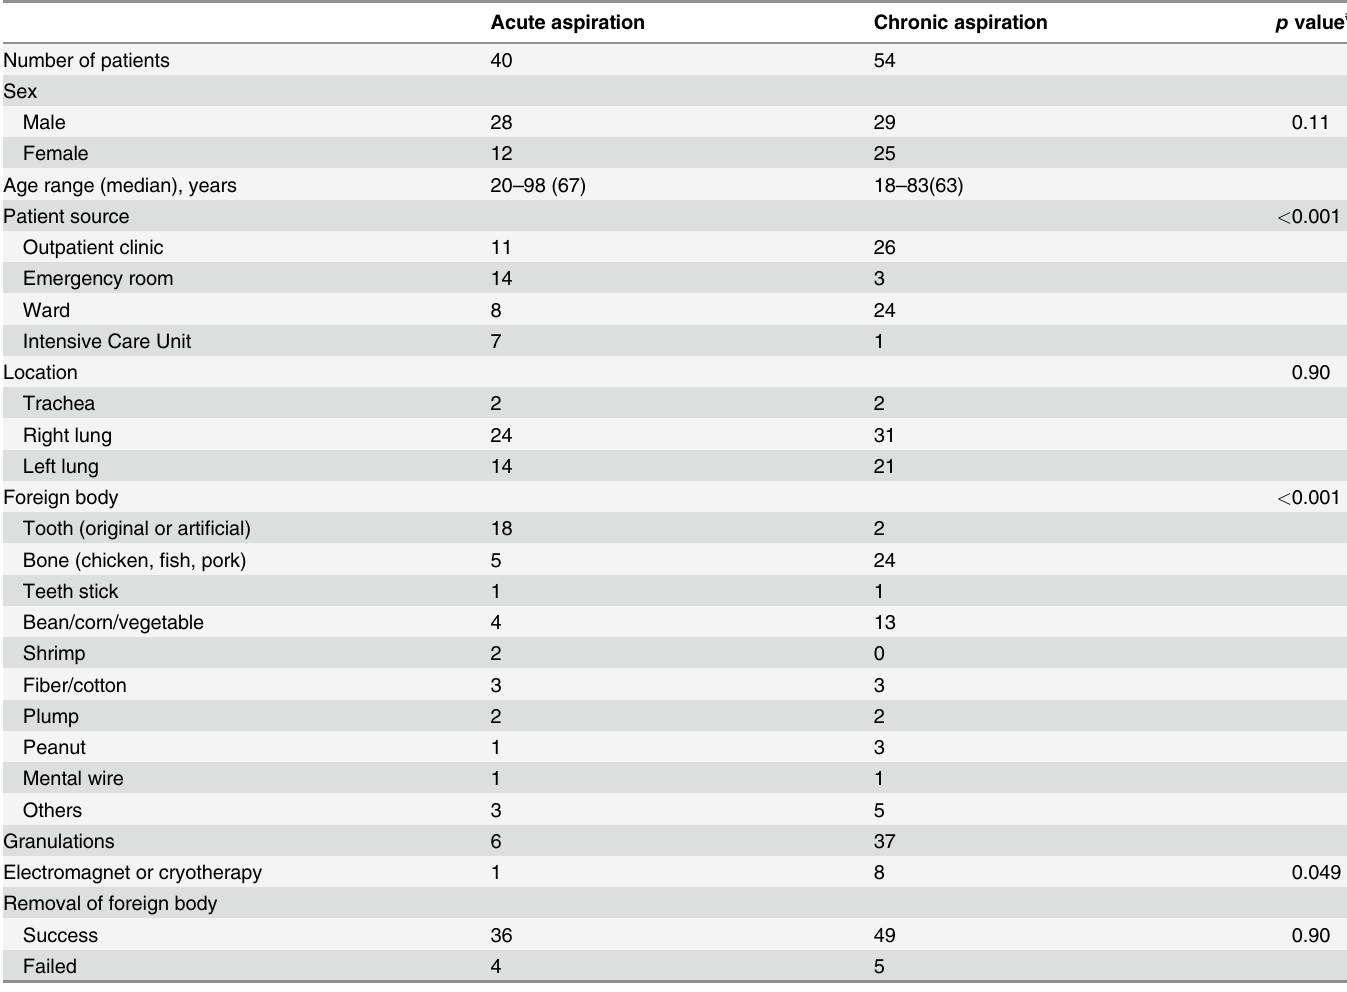
Table 2. Comparison of Patients with Acute and Chronic